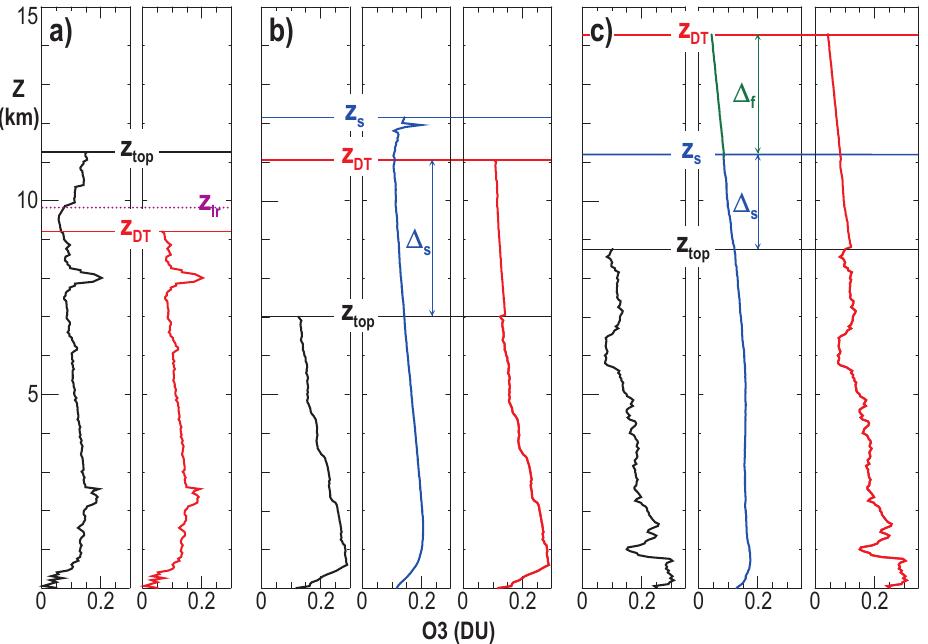
Fig. 1. Pure tropospheric profiles up to z DT , PTP ( O 3 ,z,t) (red), from three typical individual MOZAIC profiles, MP ( O 3 ,z,t) (black), using the preliminary seasonal tropospheric profile, TP ( O 3 ,z,s) (blue). For (a) z DT < z top , (b) z top < z DT < z s and (c) z DT > z s . 1 s and 1 f are the layer filled using TP ( O 3 ,z,s) (blue) and Mfit s (green), respectively. See the text for the definition of z DT , z lr , z s and z top , the horizontal lines in red, purple, blue and black, respectively.